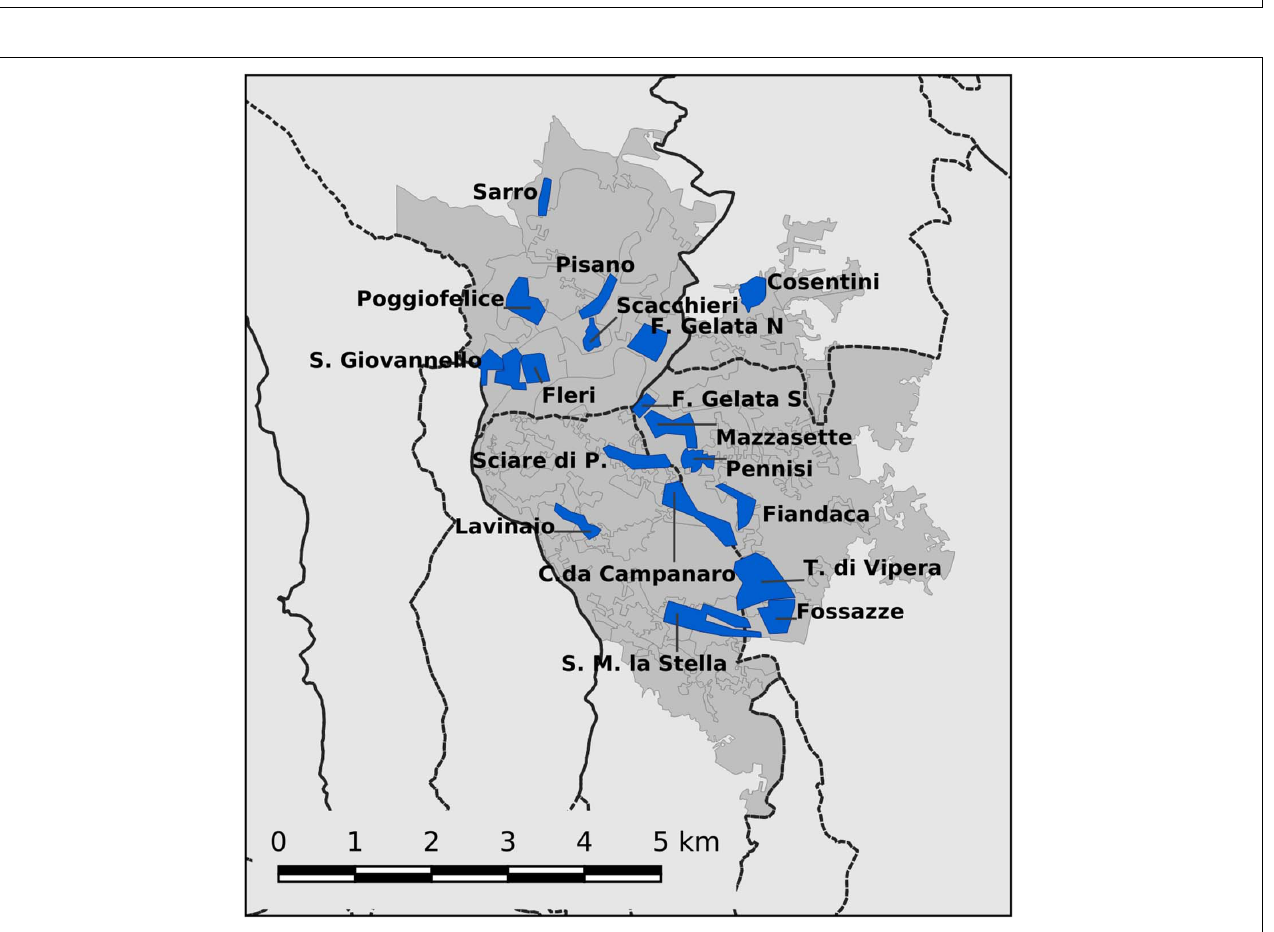
FIGURE 8 | Investigated area: ISTAT, 2011 census tracts (gray polygons) and target zones of the macroseismic survey (blue polygons). Black lines are the administrative boundaries of municipalities.